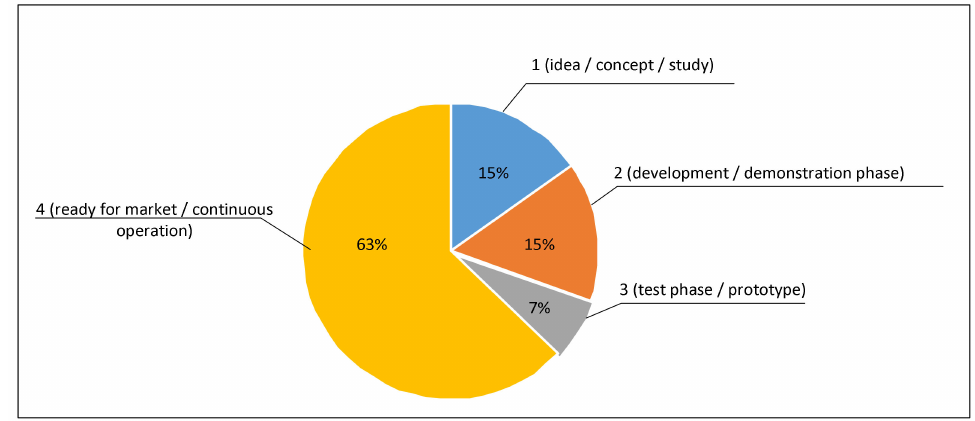
Figure 3. Development status of identified digitization elements ( n =